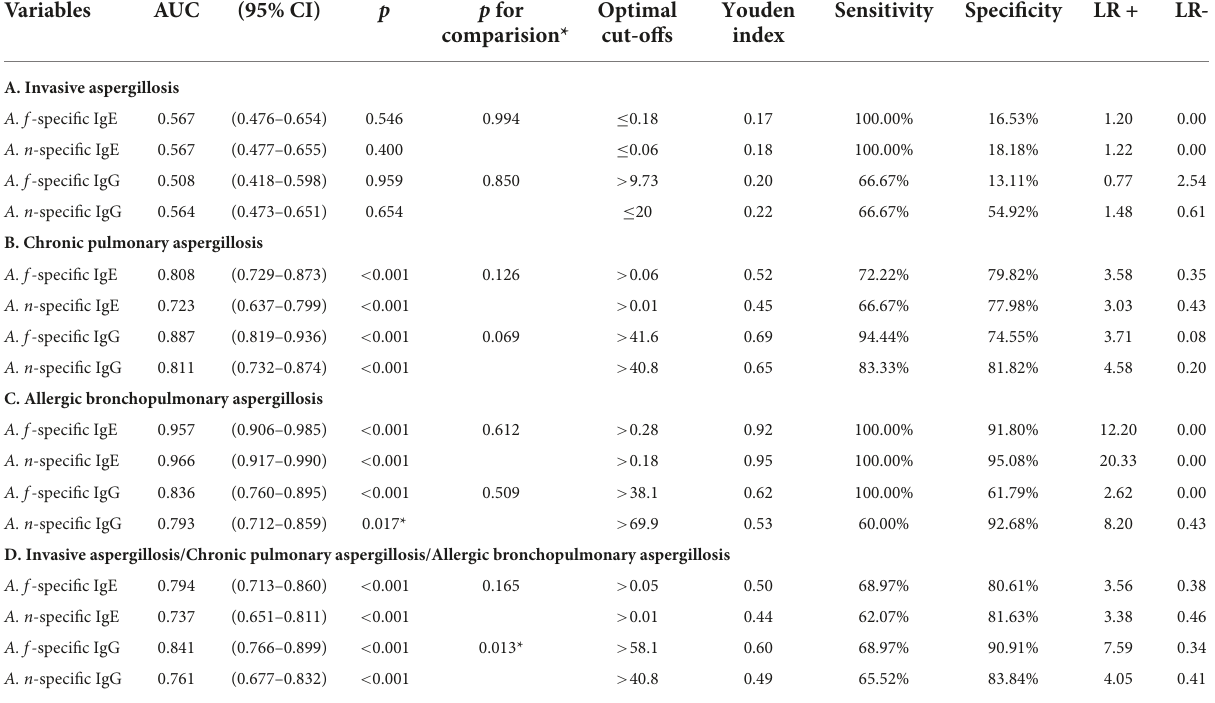
TABLE 2 Receiver operating characteristic curve (ROC) analyses of Aspergillus fumigatus - and Aspergillus niger -specific IgG and IgE for the diagnosis of aspergillosis.